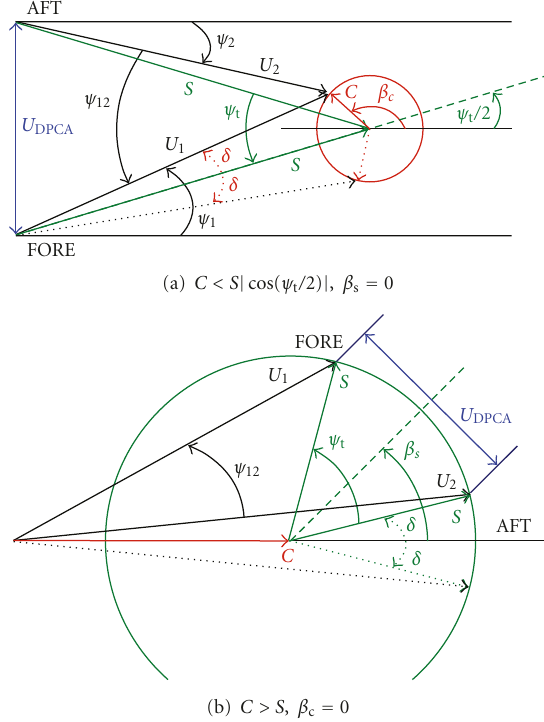
Figure 5: Phasor diagrams for an ideal noise-free case with fixed C and variable β Δ = β c − β s . Solid lines correspond to one given β Δ value, while dotted lines represent the case of an alternative, equally probable, β Δ value.